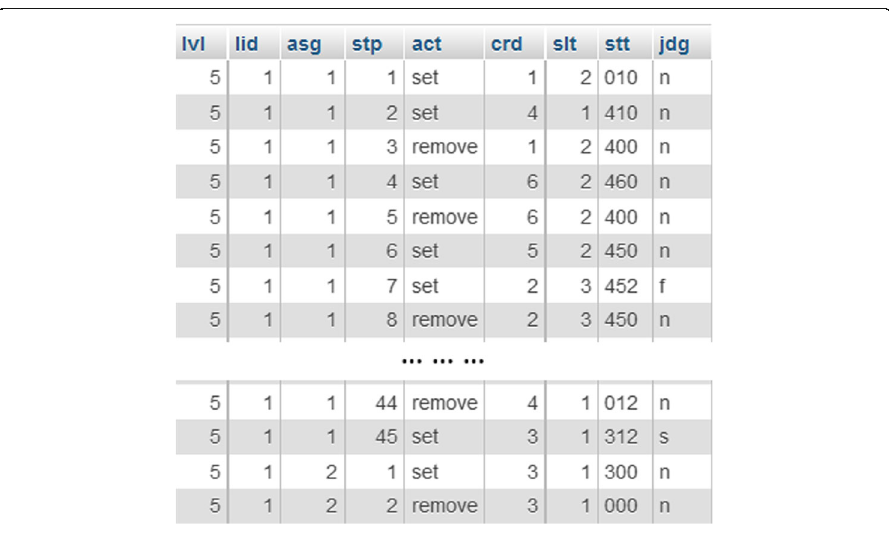
Fig. 7 Example of log data of learners ’ activity on